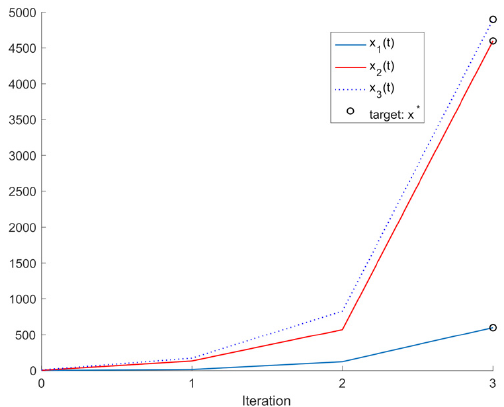
Figure 3. Evolution of stock vector x t in Example